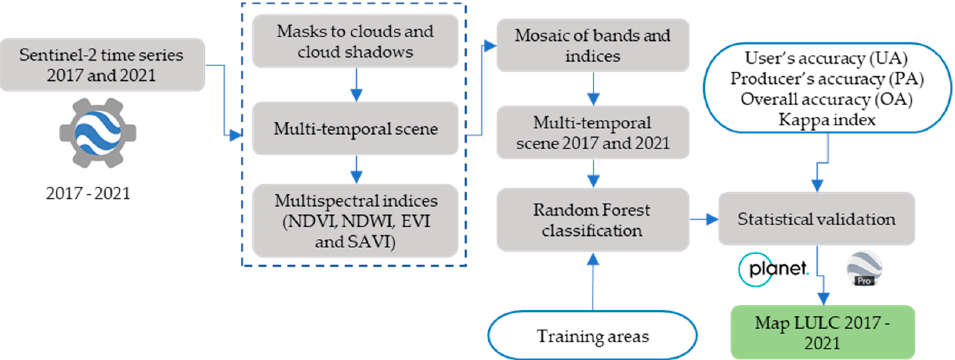
Figure 2. Methodological flow applied to analyze the LULC changes in the dry forest of the Tumbes region (Peru).